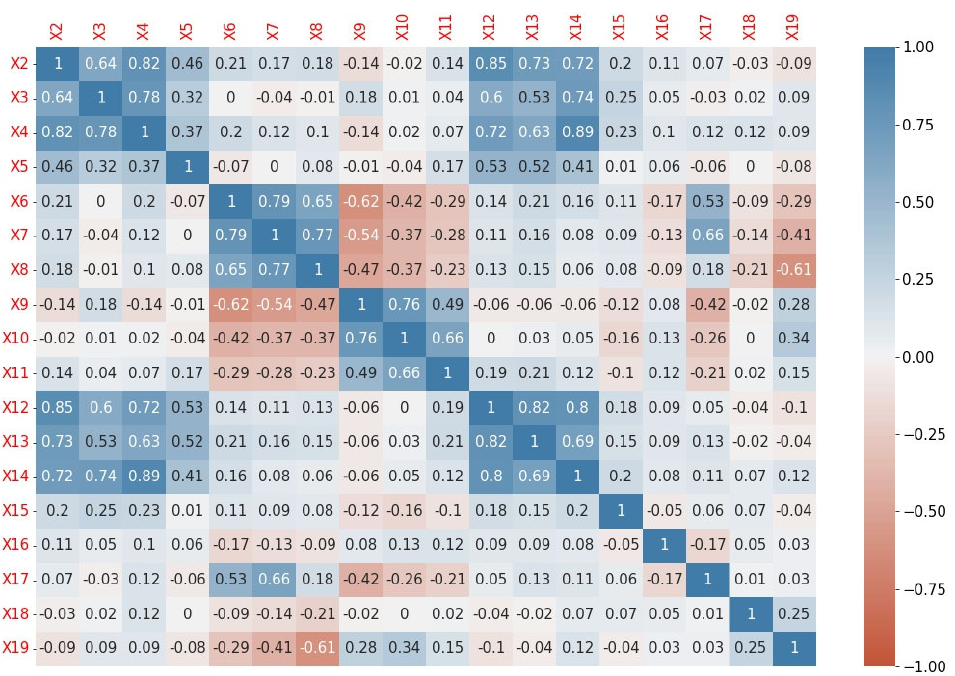
Figure 4. A plot of the Spearman rank correlation coefficient values between continuous independent variables.